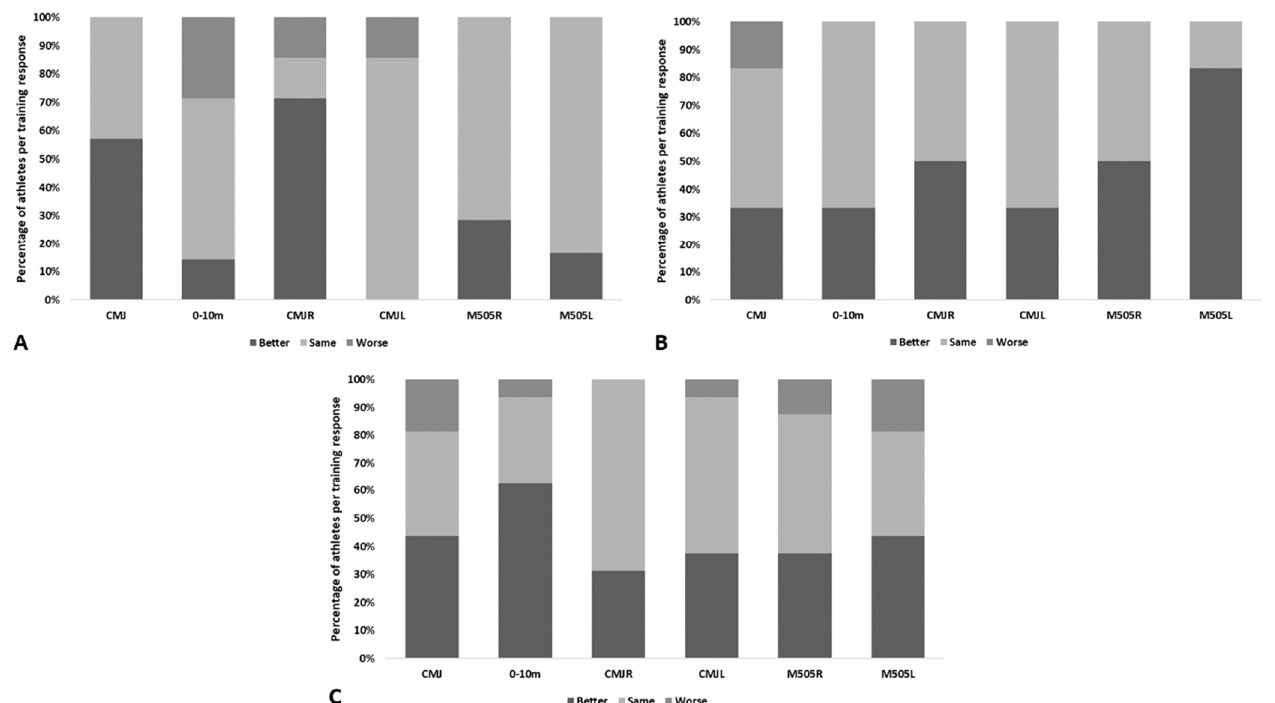
Figure 2. Percentage of athletes per training response. Legend: ( A ) Pre-PHV; ( B ) Mid-PHV; ( C ) Post-PHV.